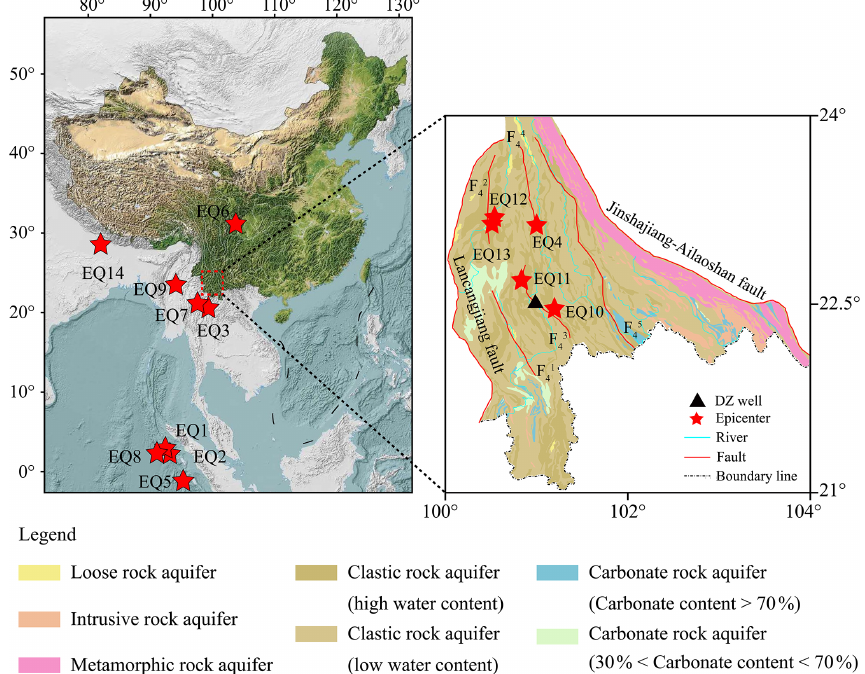
Figure 1. The hydrogeological setting of the Lanping–Simao basin. The red star indicates the distribution of 14 earthquakes, the black triangle indicates DZ well, and the solid red lines indicate faults. F 4 : the Wuliangshan fault. F 1